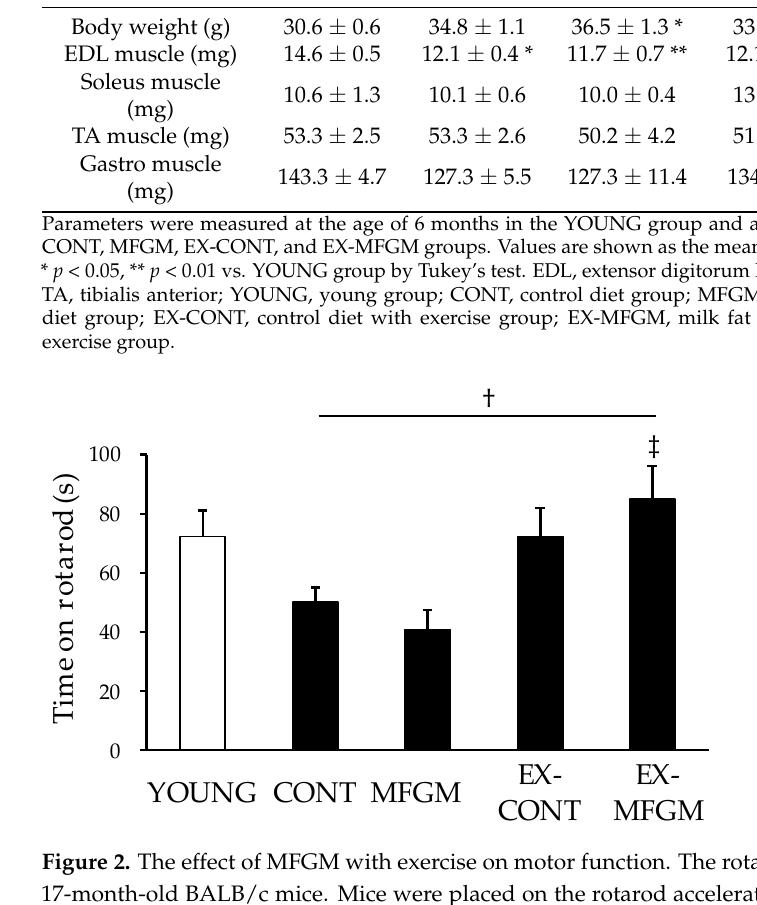
Table 1. Body and muscle weights of BALB/c mice.